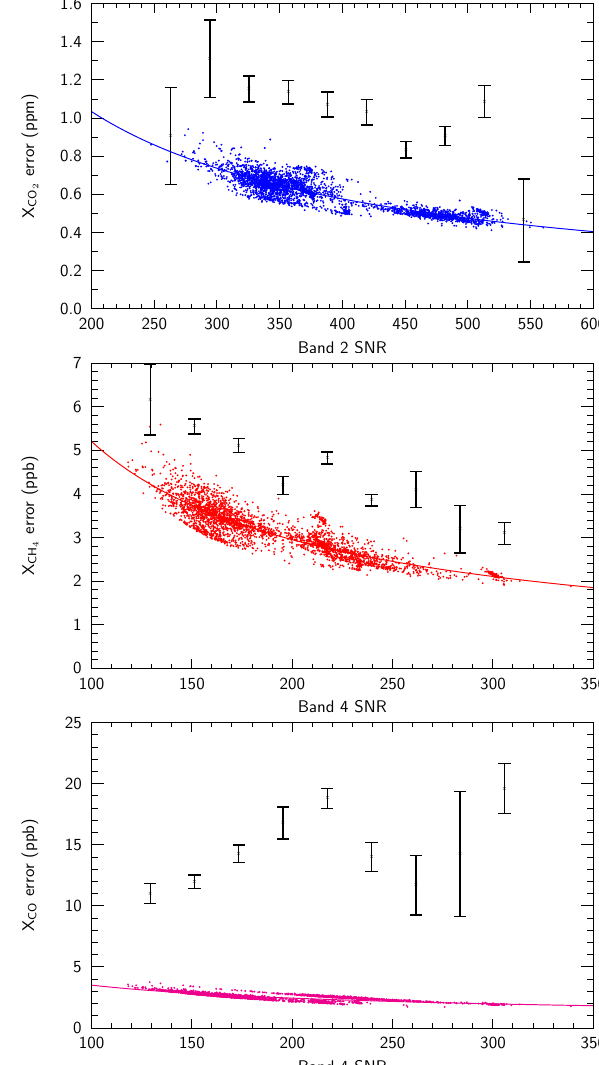
Figure 11. Posterior errors estimated by the retrieval algorithm (small dots) and actual errors (points with error bars, retrieved mi- nus the truth weighted by the averaging kernel) plotted as functions of signal-to-noise ratio for the ensemble of soundings in the Shang- hai data set that passed the PPF in experiment